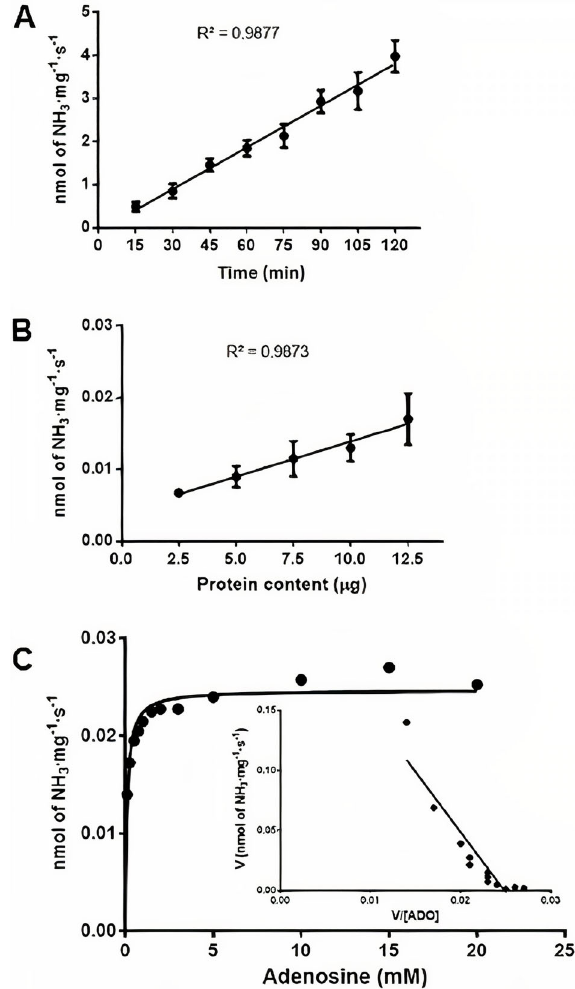
Figure 2. Enzymatic parameters of adenosine deaminase (ADA) activity in human lymphocyte-rich peripheral blood mononuclear cells. A , Effect of time on ADA activity (n=4). B , Effect of protein content on ADA activity (n=4). C , Substrate effect with Michaelis- Menten equation for determination of K m and V max and Eadie- Hofstee plot (n=4). The data are reported as means ± SE.